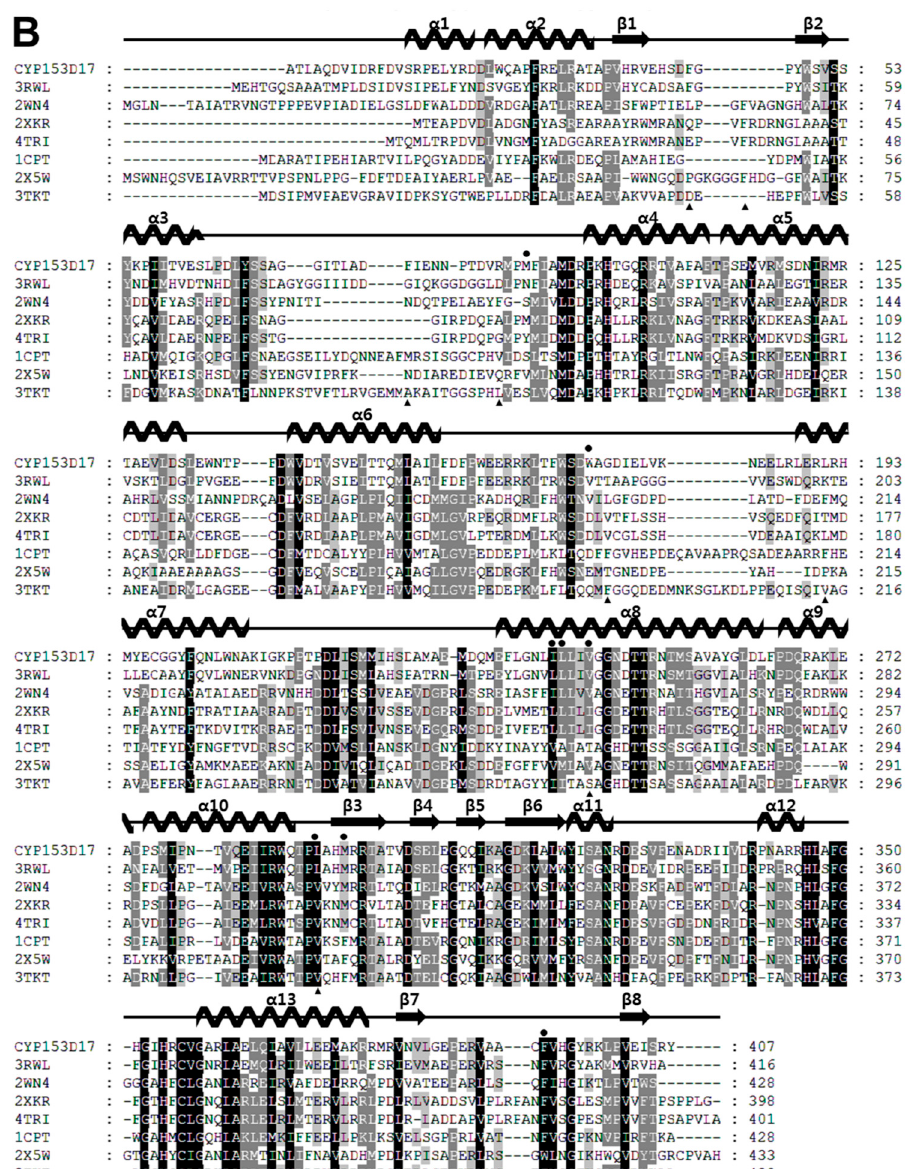
Figure 3. Crystal structure of CYP153D17. ( A ) The overall structure of CYP153D17 is shown as a ribbon diagram with α -helices colored slate blue and β -strands colored magenta. The bound heme molecule (green) and co-purified ligand (yellow) are shown in the stick model. N- and C-termini are labeled. The right-panel figure is rotated counterclockwise 90° from the left-panel figure; ( B ) Multiple sequence alignment of CYP153D17 (NCBI reference sequence, WP_010183267.1), P450pyr (PDB code, 3RWL; UniProtKB code, Q5F4D9), CYP124 (PDB code, 2WM4; UniProtKB code, P9WPP3), CYP142 (PDB code, 2XKR; UniProtKB code, P9WPL5), CYP142A2 (PDB code, 4TRI; UniProtKB code, A0R4Q6), P450terp (PDB code, 1CPT; UniProtKB code, P33006), CYP125 (PDB code, 2X5W; UniProtKB code, P9WPP1), and CYP108D1 (PDB code, 3TKT; UniProtKB code, Q2G3H6). Highly conserved residues are shaded in black and similar residues are in gray. The secondary structural elements in the crystal structure of CYP153D17 are shown above the multiple sequence alignment. The residues involved in binding of the co-purified ligand in CYP153D17 are indicated by a black circle above the sequence alignment, and those involved in phytanic acid binding in the CYP124 structure, by a black triangle below the sequence alignment. Multiple sequence alignment was performed using ClustalX (version 1.81) [22] and edited using GeneDoc (Ver 2.5.000) [23].